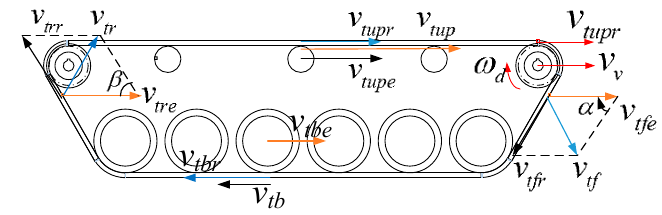
Figure 6. Track velocity analysis in each section.